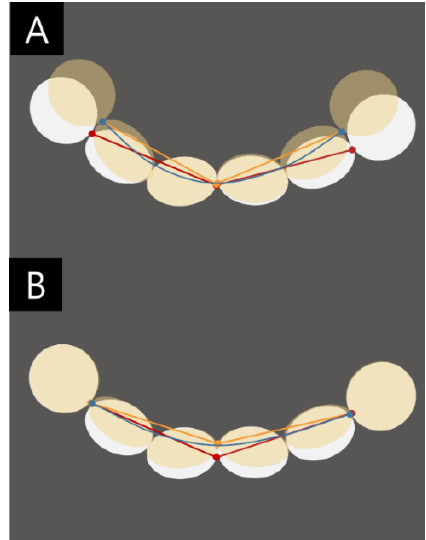
Figure 4. Illustration of differences in the sectional anterior arch length measurement caused by a distortion of intraoral scanning ( A ) and arch shape distortion. ( B ). Tooth labial-lingual width distortion. Red line: actual, yellow line: difference by distortion, blue line: curved arch.